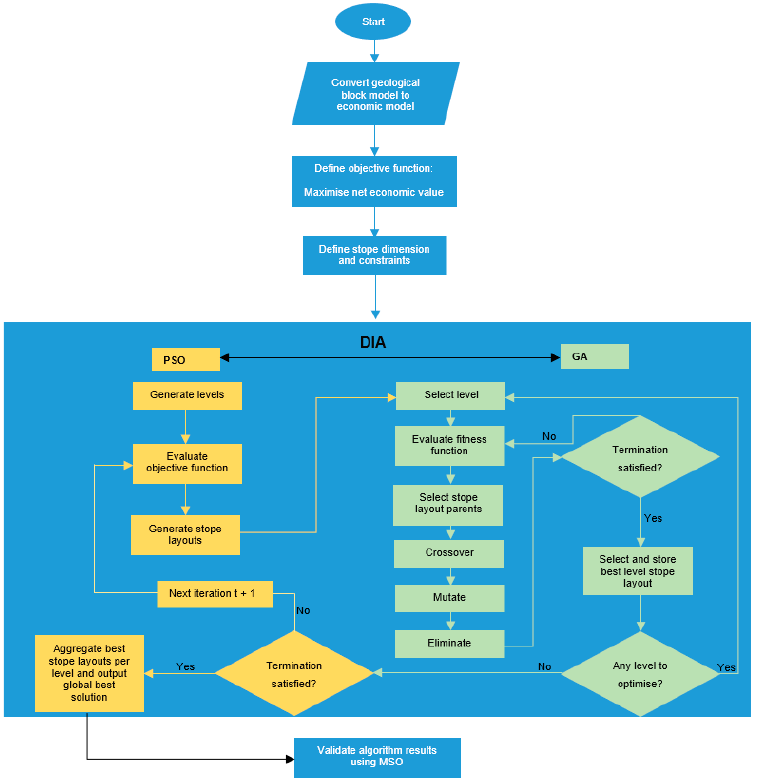
Figure 4. Schematic illustration of the proposed dual interchange algorithm integrating the PSO and GA. Source: [3].